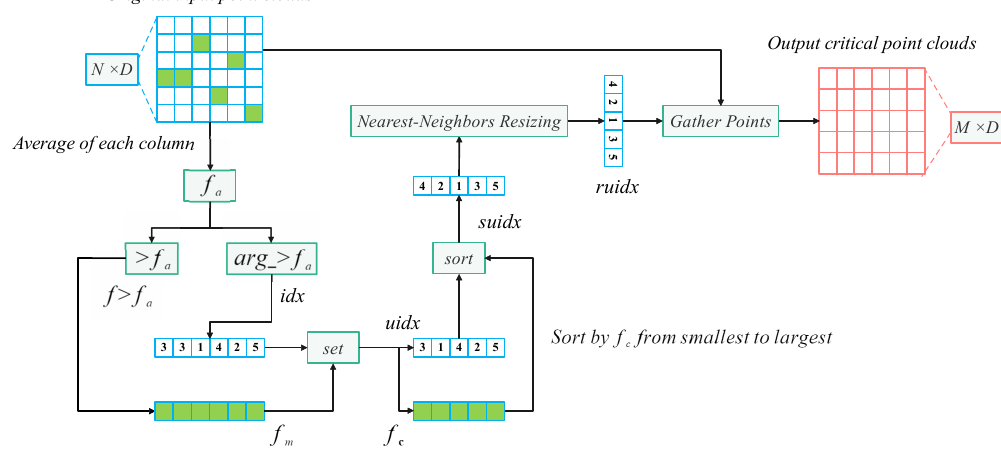
Figure 5. The description of selective downsampling layer.